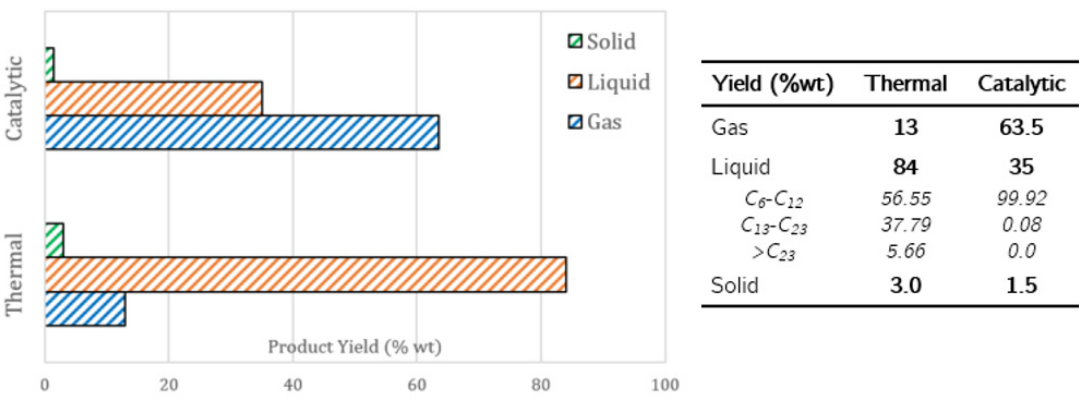
Figure 3. Product yield comparison between thermal and catalytic pyrolysis of HDPE. Graph adapted from Seo et al. data [43].